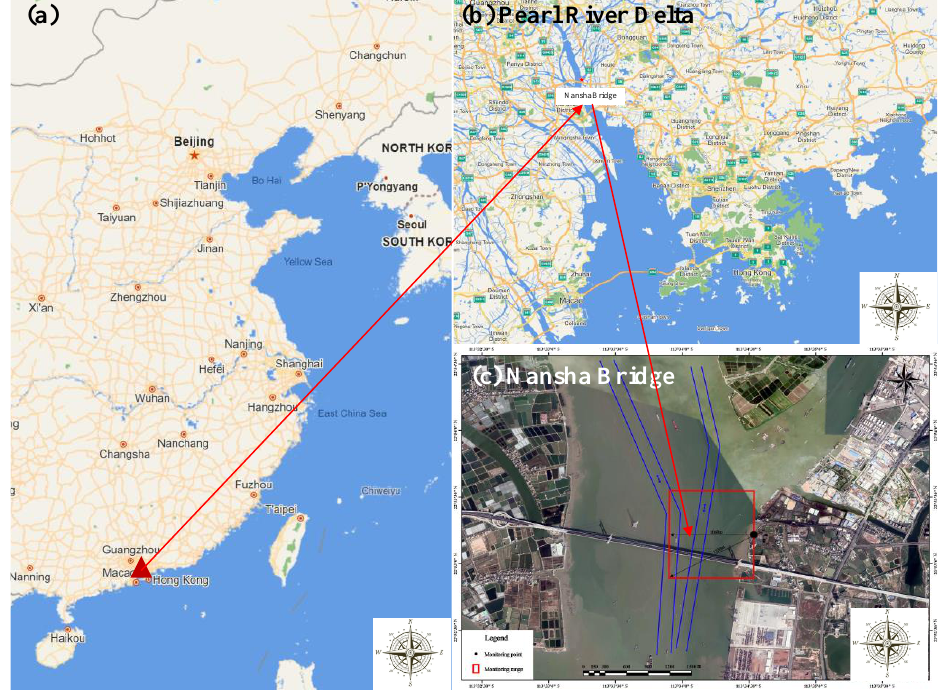
Figure 1. ( a ) The location of the Pearl River Estuary. ( b ) The area of the Pearl River Estuary. ( c ) The area and scope monitored by